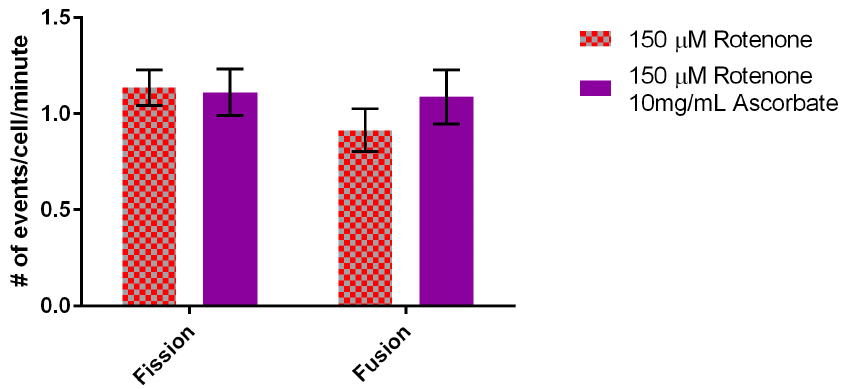
Figure 9. Effect of rotenone and 10 mg/mL ascorbic acid on mitochondrial fission and fusion rates. 10 mg/mL ascorbic acid increased fusion rates back to normal levels (statistically no significant difference) when compared to rotenone treated cells ( n = 30). Error bars represent standard error.